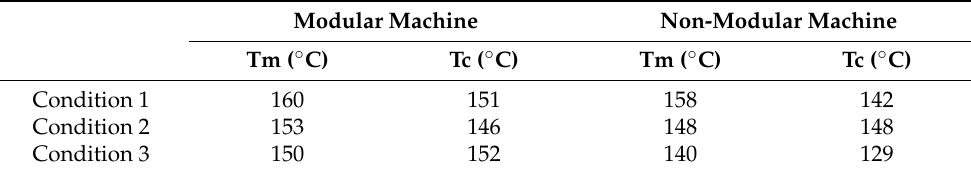
Table 3. Average steady state of the PM and coil temperatures.